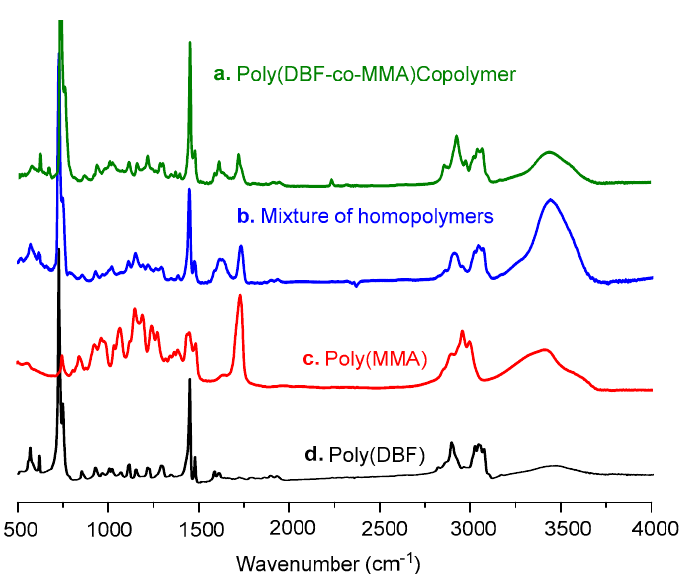
Figure A1. IR spectra of poly(DBF- co -MMA) (run 2 in Table 1, [DBF]/[MMA] = 82/18 in polymer) (a), a mixture of poly(DBF) (run 17 in Table 1) and poly(MMA) (run 1 in Table 1) at a residue molar ratio of 85/15 (b), poly(MMA) (run 1 in Table 1) (c), and poly(DBF) (run 17 in Table 1) (d). [KBr pellet].